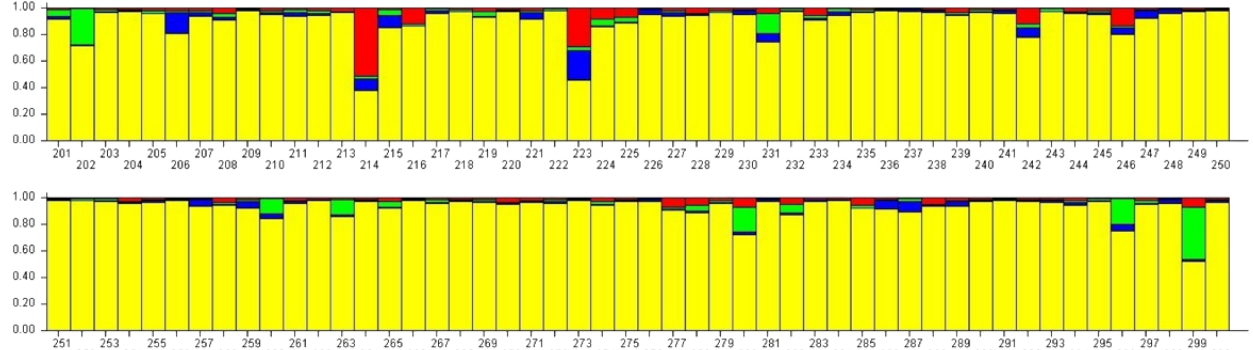
Figure 4. Cluster of PC boars by